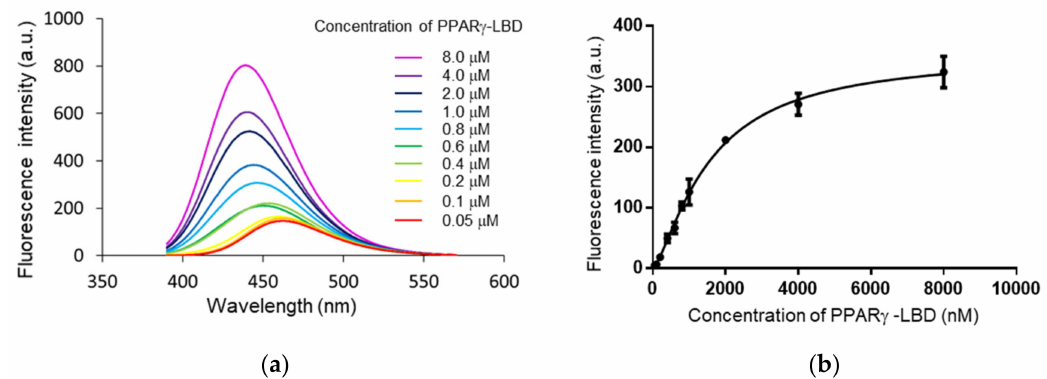
Figure 7. ( a ) Fluorescence spectra of 2 (1 µ M) upon addition to hPPAR γ -LBD (0.05–8.0 µ M) in Tris–HCl buffer with Ex = 367 nm. ( b ) Fluorescence intensity of 2 at 410 nm depending on the concentration of hPPAR γ -LBD. Data are mean ± SD (n = 3).